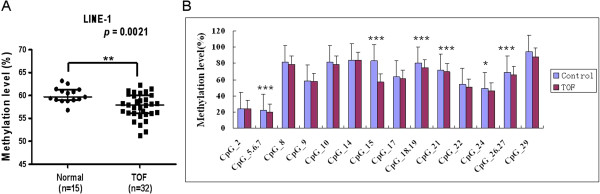
(A) Median methylation levels of long interspersed nucleotide element-1 (LINE1) between control and TOF subjects. (B) Median methylation levels of 14 informative CpG units in LINE-1 between control and TOF subjects. Control, n = 15; TOF, n = 32. *P <0.05, **P < 0.01, ***P < 0.001 (Mann–Whitney U test)